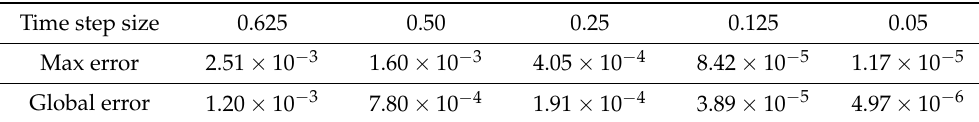
Table 2. Max and global errors of hydraulic head H with different time step size.